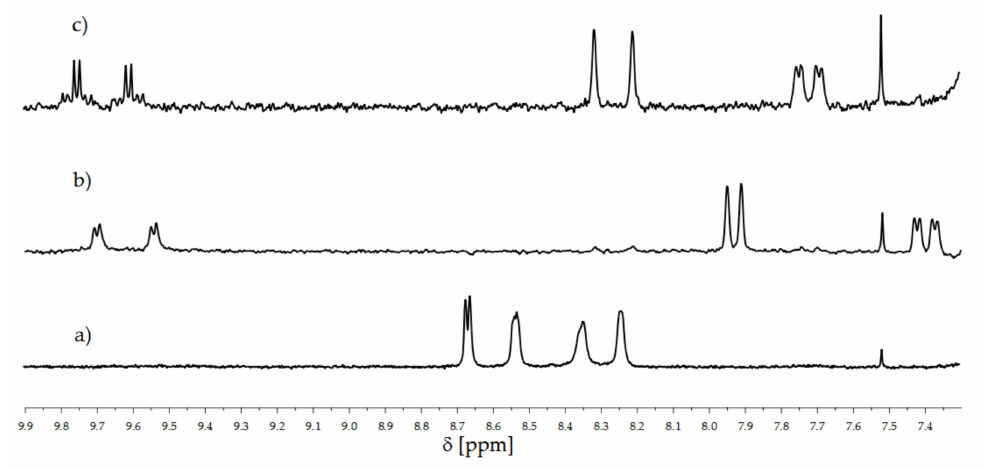
Figure 3. Magnification of the NMR spectra in the aromatic region of ( a ) PLLA-Bipy, ( b ) Pt(PLLA-Bipy)Cl 2 and ( c ) [Pt(PLLA-Bipy)Cl 2 ] 2 recovered after ID4.